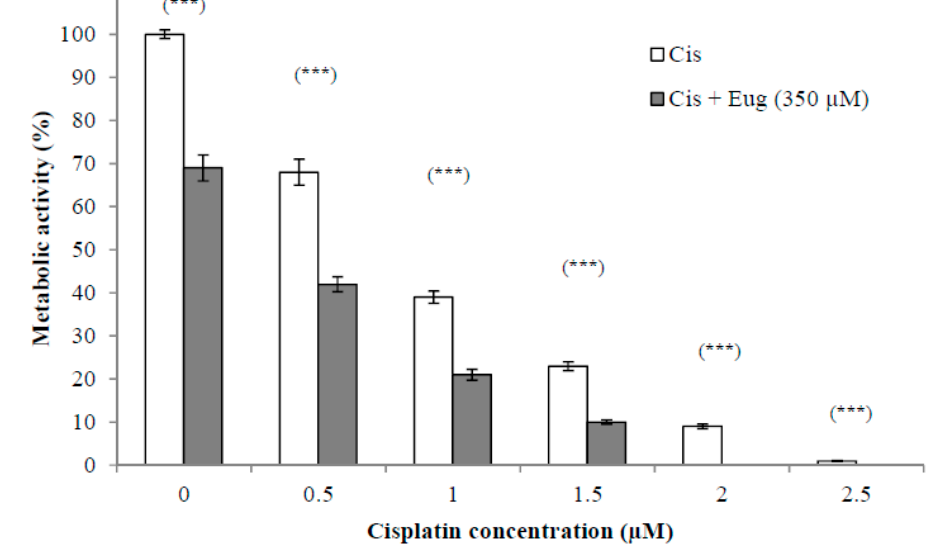
Figure 2. Effect of eugenol on sensitivity of HeLa cells to cisplatin. HeLa cells were treated , in triplicate, with different concentrations (0–2.5 µM) of cisplatin alone or in combination with eugenol (350 µM) for 24 h. The survival of cells, estimated by CCK-8, was expressed as a percentage relative to that of cells treated with medium only (without cisplatin or eugenol). Data represent mean ± SD. Significant difference was analyzed by one-way ANOVA test, where *** p < 0.001 compared to cells not treated with eugenol.